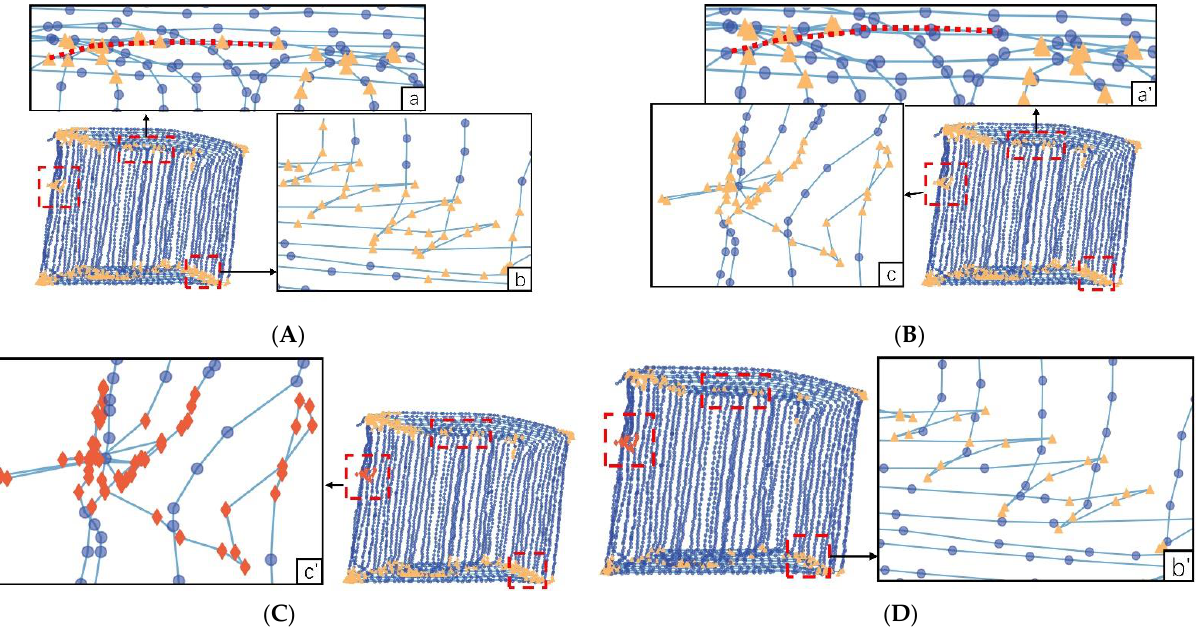
Figure 5. Step-by-step results of in-field trajectory identification of wheat harvester. ( A ) D-K-means results; ( B ) D-K-means + M1 results; ( C ) D-K-means + M1 + M2 results; ( D ) D-K-means + M1 + M2 + M3 results. (a) The working trajectory is mistakenly identified as the turning trajectory; ( a’ ) The result after correcting the part a with the correction M1; (b) Turning trajectory obtained after D-k-means; ( b’ ) Turning trajectory obtained after the correction M3; (c) The abnormal working trajectory is mistakenly identified as the turning trajectory; ( c’ ) The result after correcting the part c with the correction M2. Yellow triangle is the turning trajectory point, blue circle is the working trajectory point, orange diamond is the abnormal working trajectory point.